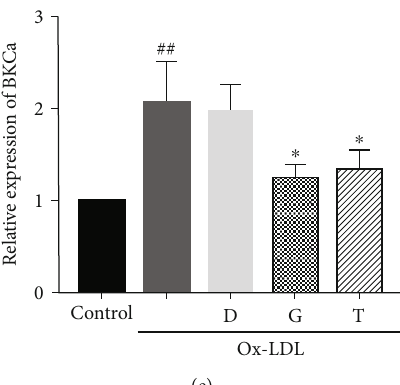
Figure 5: E ff ect of genistein, tyrphostin 23, and daidzein on protein expression and current level of BKCa channels. (a) Representative BKCa currents. (b) I ‐ V curves of BKCa currents. (c) BKCa peak current densities at the test potential of -80mV. The results indicated that perfusion with genistein and tyrphostin 23 reversed Ox-LDL-enhanced BKCa currents. ## P < 0 : 01 vs. control, ∗ P < 0 : 05 vs. Ox-LDL. (d) Western blot analysis and (e) statistical analysis of BKCa channels. The results indicated that genistein and tyrphostin 23 reversed Ox-LDL-enhanced BKCa protein expression. ## P < 0 : 01 vs. control, ∗ P < 0 : 05 vs. Ox-LDL. All values are expressed as the mean ± SD ( n = 3 ). Daidzein had no signi fi cant e ff ect on protein expression and current level of BKCa channels. Abbreviations: D: daidzein; G: genistein; T: tyrphostin